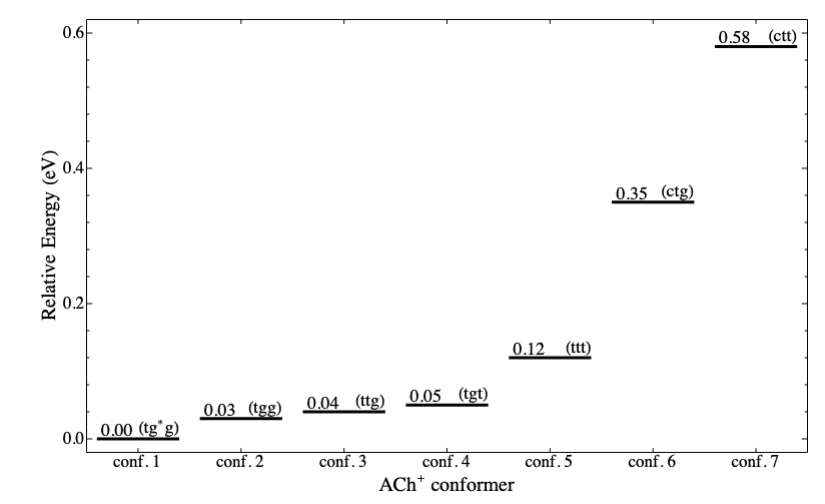
Figure 4. The energy level diagram (ELD) of the seven stable ACh + conformers. The energy is relative to ACh + (tg ∗